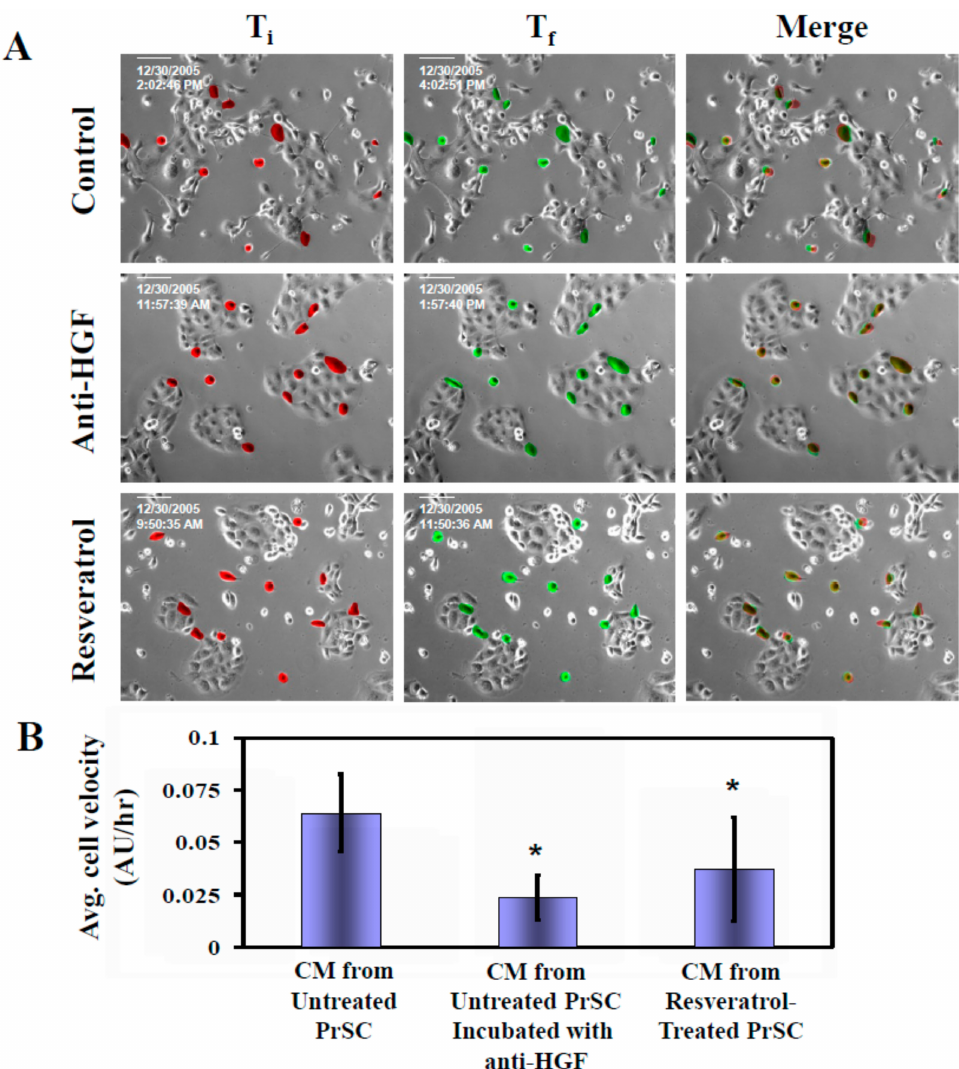
Figure 5. E ff ect of resveratrol and anti-HGF on CM-mediated migration of DU145 cells. ( A ) Time lapse microscopy analyses were performed to monitor the changes on DU145 cell migration for 2 h in cells treated with CM, with and without prior addition of excess of anti-HGF. Images were taken at initial time at time 0 (T i ) and finish time at 2 h (T f ). A Zeiss microscope equipped with Axiovert 2000 Imagining system (Carl Zeiss MicroImaging, Jena, Germany) was used to capture cell images at 20 × magnification. Two images were merged as described in Supplementary Materials. ( B ) Calculated changes on the average cell velocity and average distance traveled in DU145 cells treated with CM, with and without prior addition of excess of anti-HGF (* p < 0.05). Asterisks (*) indicated statistically significant di ff erence between treated groups compared with